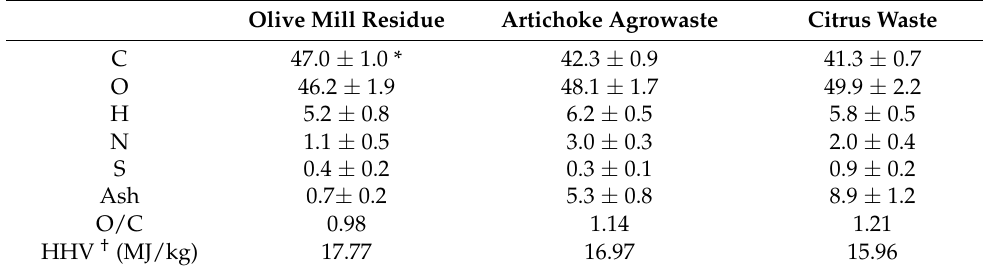
Table 1. Ultimate analysis (wt, %, db) of selected agrifood